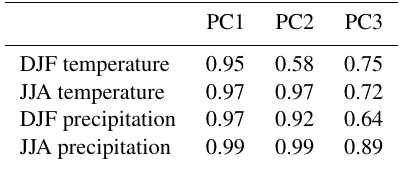
Table 3. R 2 correlation between PC scores from SVD and PC scores emulated with the linear